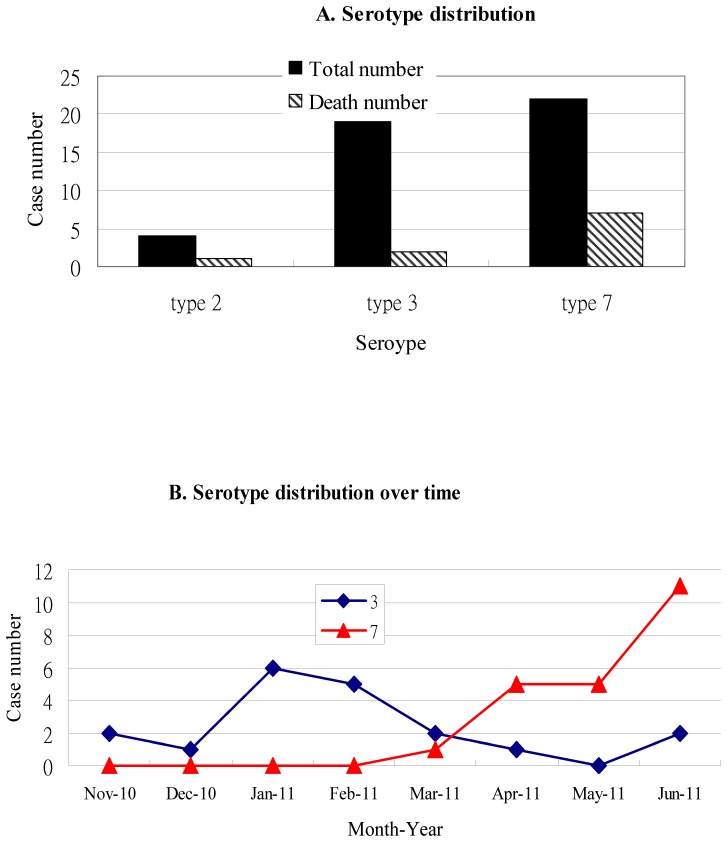
Serotype distribution.